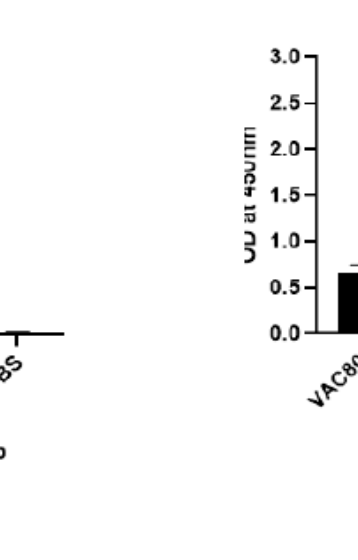
to the CpG ODNs and 8 × 10 9 VP of vaccinated mice ( p < 0.06) (Figure 3). For the 8 × 10 9 VP vaccine concentration, high IgG antibody titers were shown compared to 4 × 10 9 VP. Figure 3. IgG antibody response to SARS-CoV-2 using ELISA assays on days 14 and 28. The IgG response was significantly stronger in the 4 × 10 9 VP of vaccine supplemented by CpG ODNs mice, compared to the CpG ODNs and 8 × 10 9 VP of vaccinated mice ( p < 0.06). 3.2. Evaluation of mRNA Expression on Immunized Mice